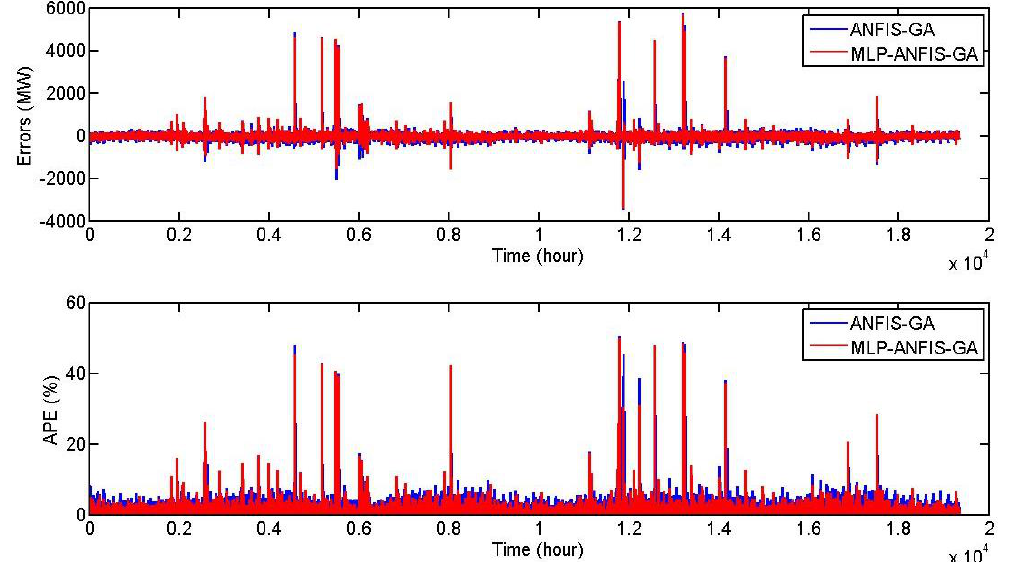
Figure 9. Errors and APE (%) for ANFIS-GA and MLP-ANFIS-GA models.